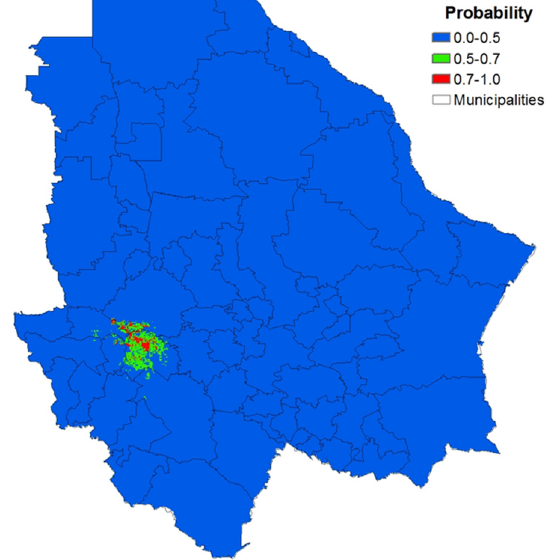
Figure 6. Map of potential distribution of Picea chihuahuana Martínez in Chihuahua, Mexico: model at state